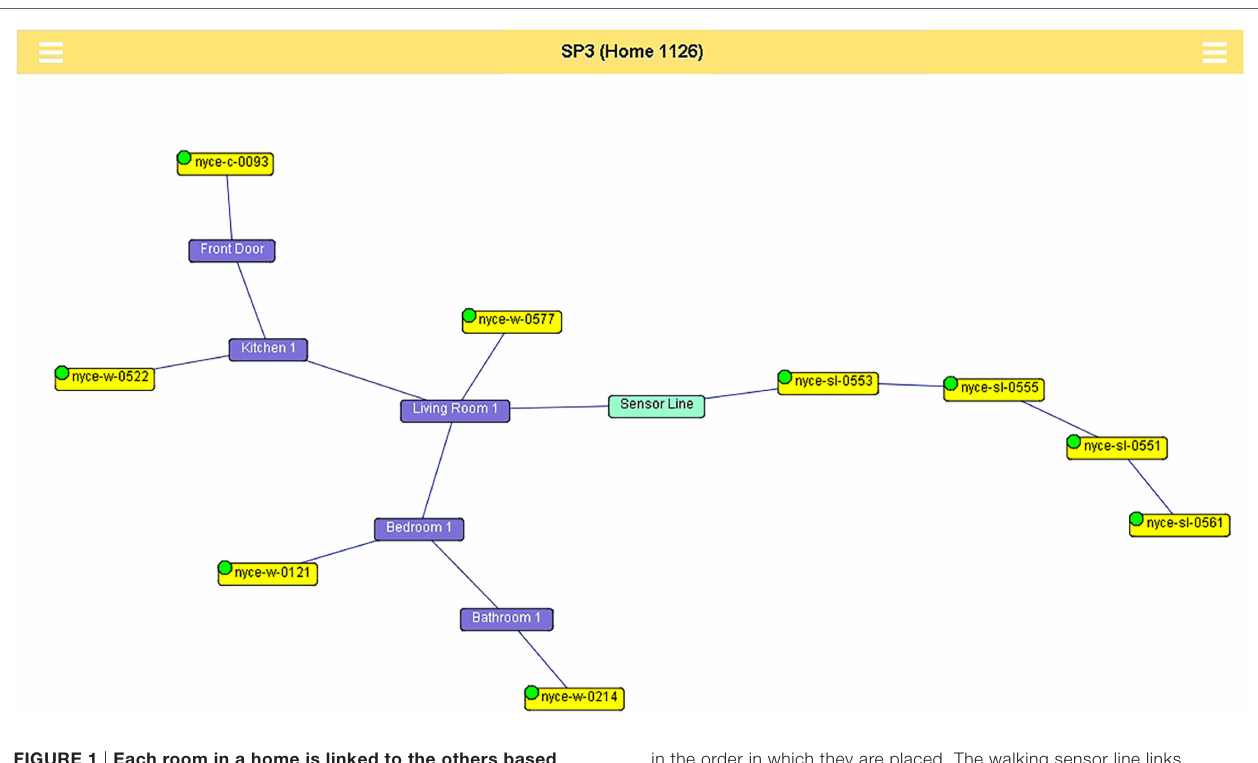
FIGURe 1 | each room in a home is linked to the others based on valid room transitions . Passive infrared sensors are linked to the rooms in which they are located. The walking sensor line is an area, consisting of four restricted field passive infrared sensors linked together